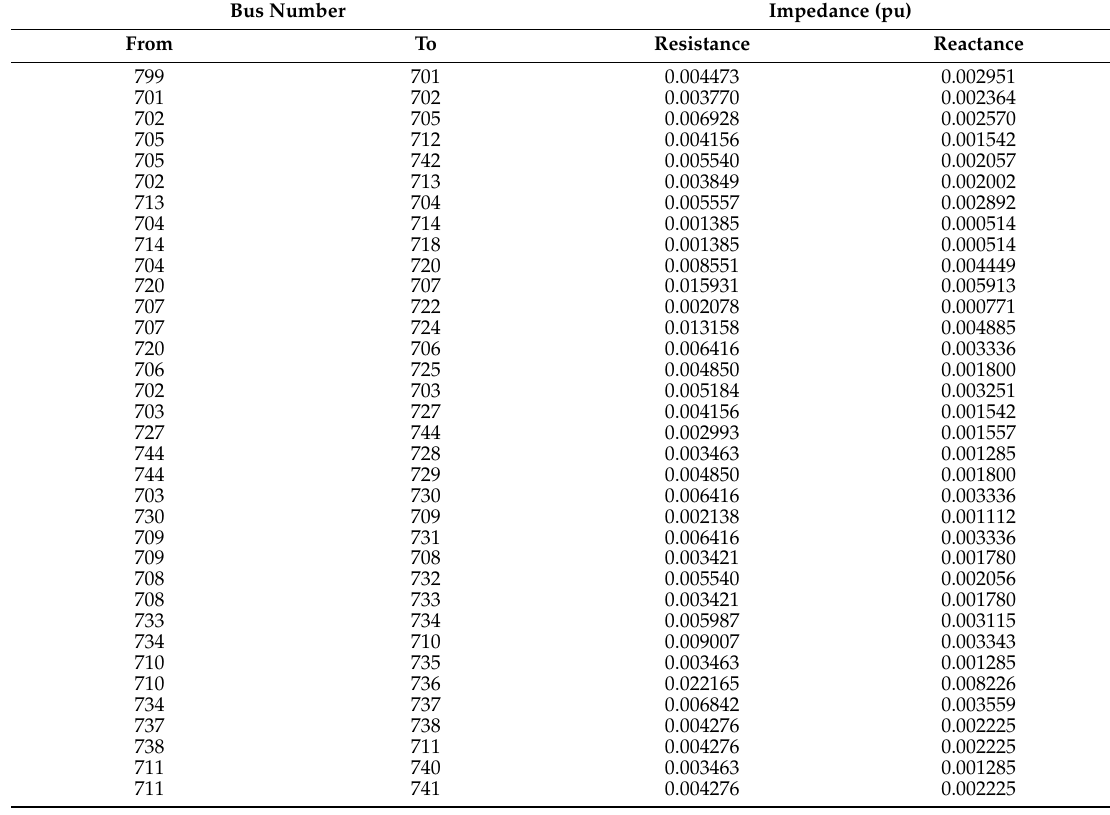
Table 2. Line data of the